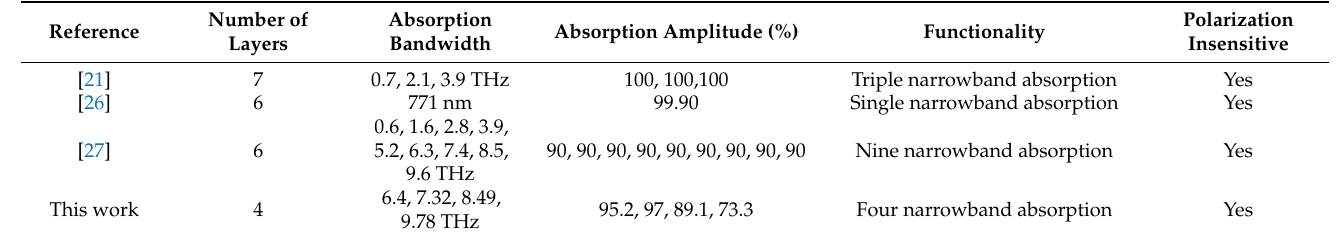
Table 3. Comparison of the narrowband absorption performance between different